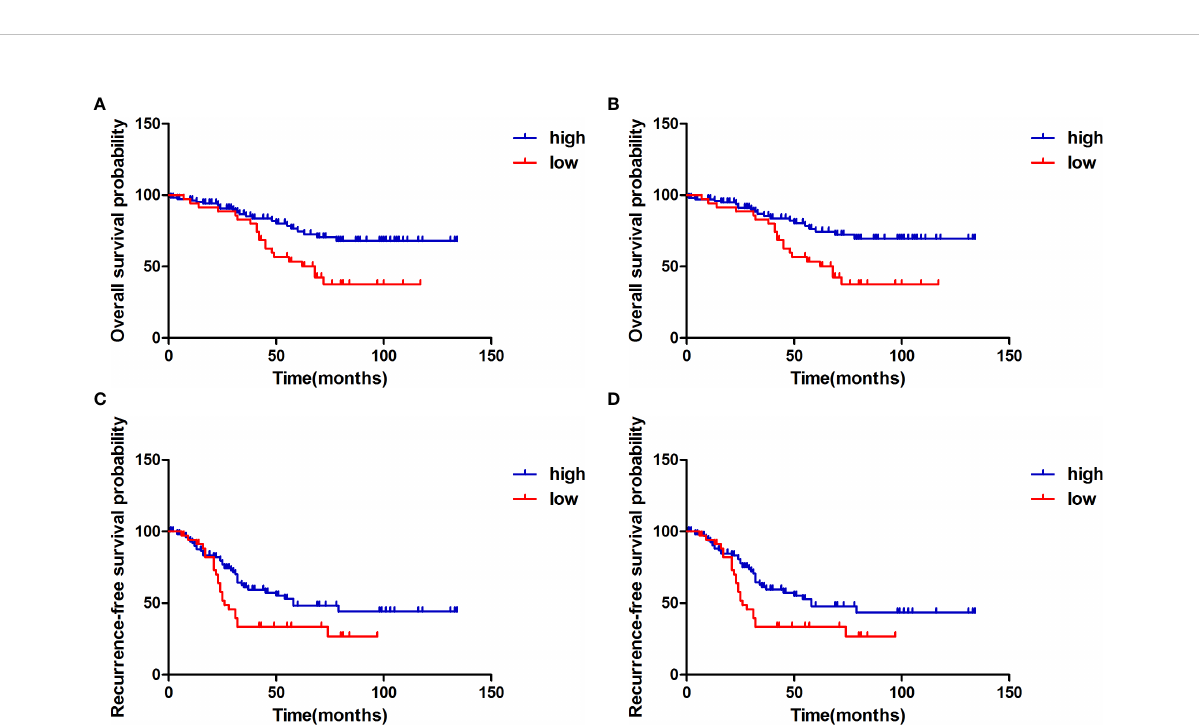
FIGURE 3 Kaplan-Meier survival curve with log-rank test derived results of survival analysis. (A) Overall survival of 145 chordoma patients stratifed by the expression status of H3K27me3 in all patients, (B) Overall survival of 139 conventional chordoma patients stratifed by the expression level of H3K27me3. (C) Recurrence-free survival of 145 chordoma patients stratifed by the expression level of H3K27me3 in all patients, (D) Recurrence- free survival of 139 conventional chordoma patients stratifed by H3K27me3 status. Compared to the high expression group, patients with low H3K27me3 expression had signi fi cantly shorter overall survival and recurrence-free survival.